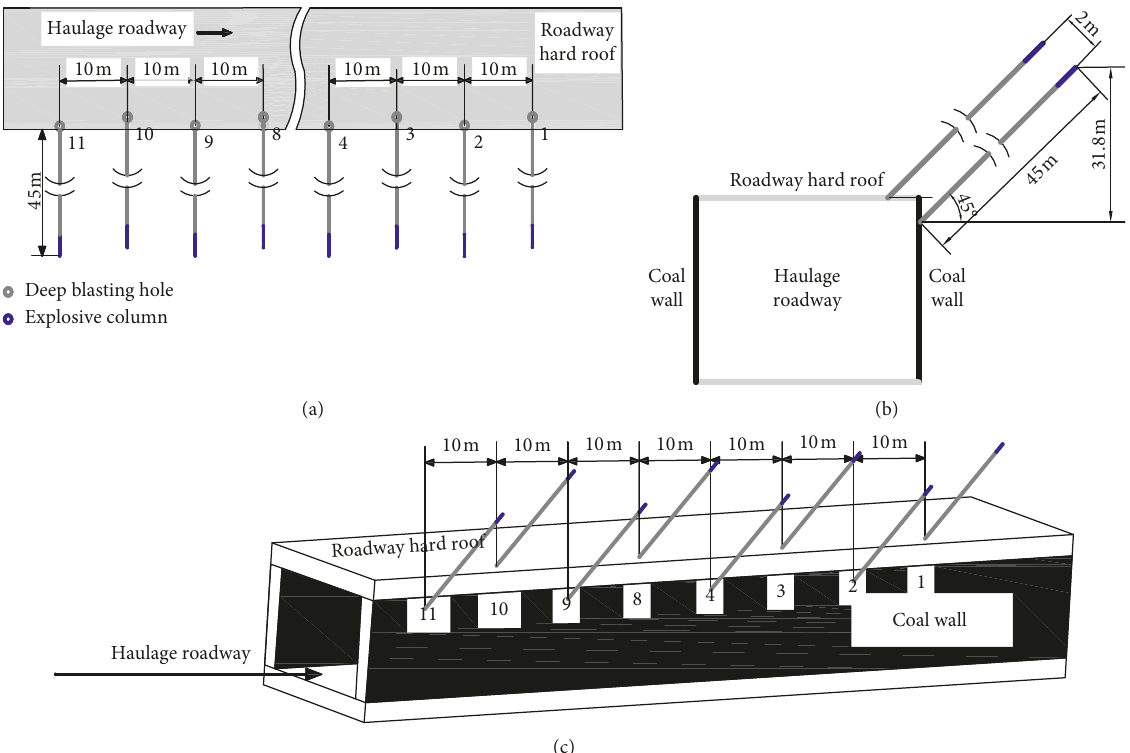
Figure 8: “Triangular-fractal” blasting layout. (a) Top view of blasting layout. (b) Cross-sectional view of blasting layout. (c) 3D drilling position.